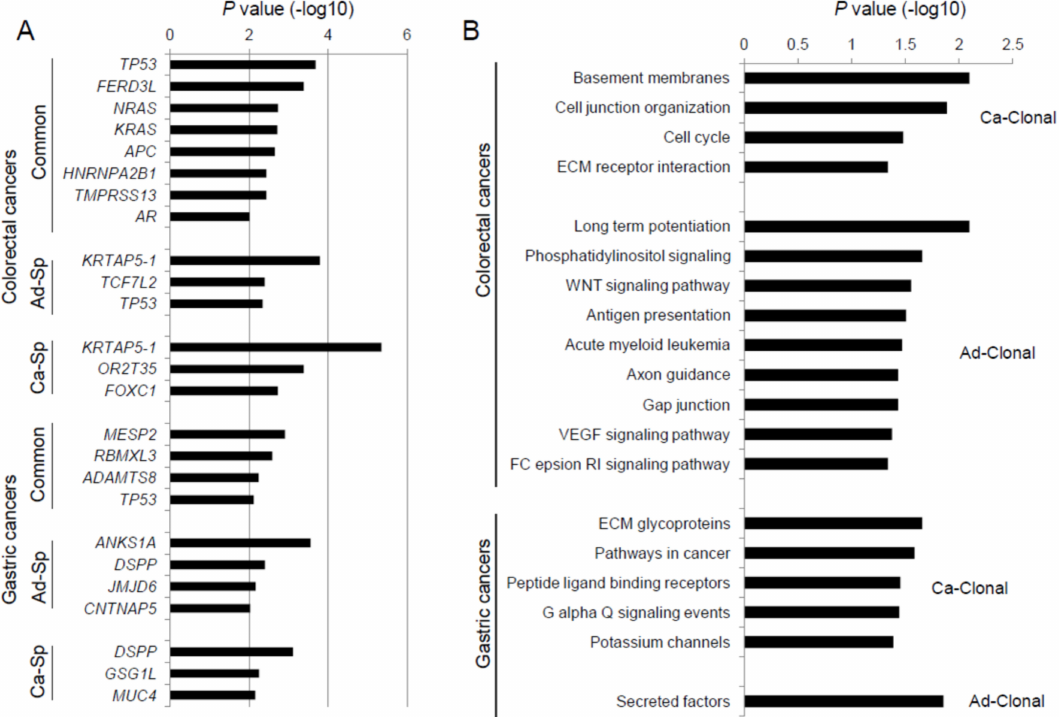
Figure 2. Recurrent mutations in region-specific classes. ( A ) Genes substantially enriched with three regional mutation categories ( p < 0.01; MutSigCV) are shown for colorectal and gastric cancers. Common (lesion-common) mutations are shown with Ad-Sp and Ca-Sp (adenoma- and carcinoma-specific, respectively). ( B ) Gene sets are shown for those enriched with Ca-Clonal and Ad-Clonal mutations (those CCF carcinoma > CCF adenoma and CCF carcinoma < CCF adenoma ,